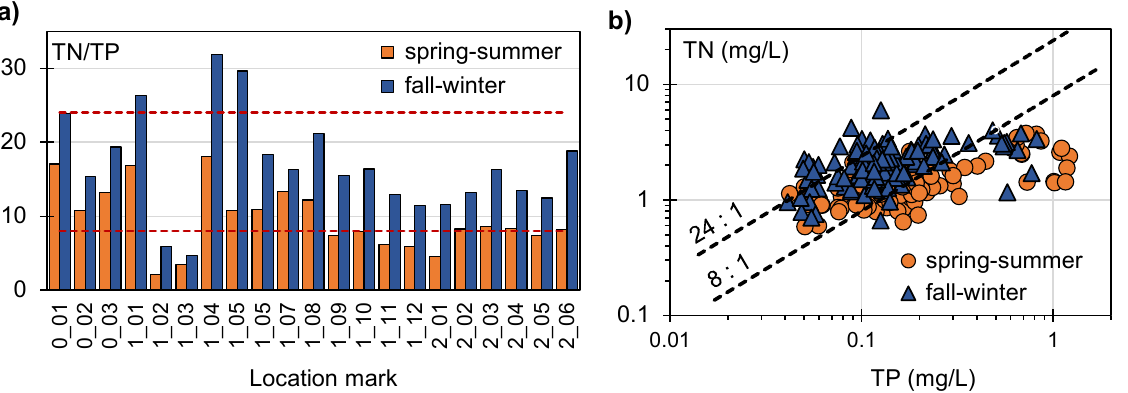
Figure 5. Distribution of TN:TP mass ratio, and % values in different TN:TP ratio ranges, with dashed red lines at particular (8, 16 and 24) threshold.